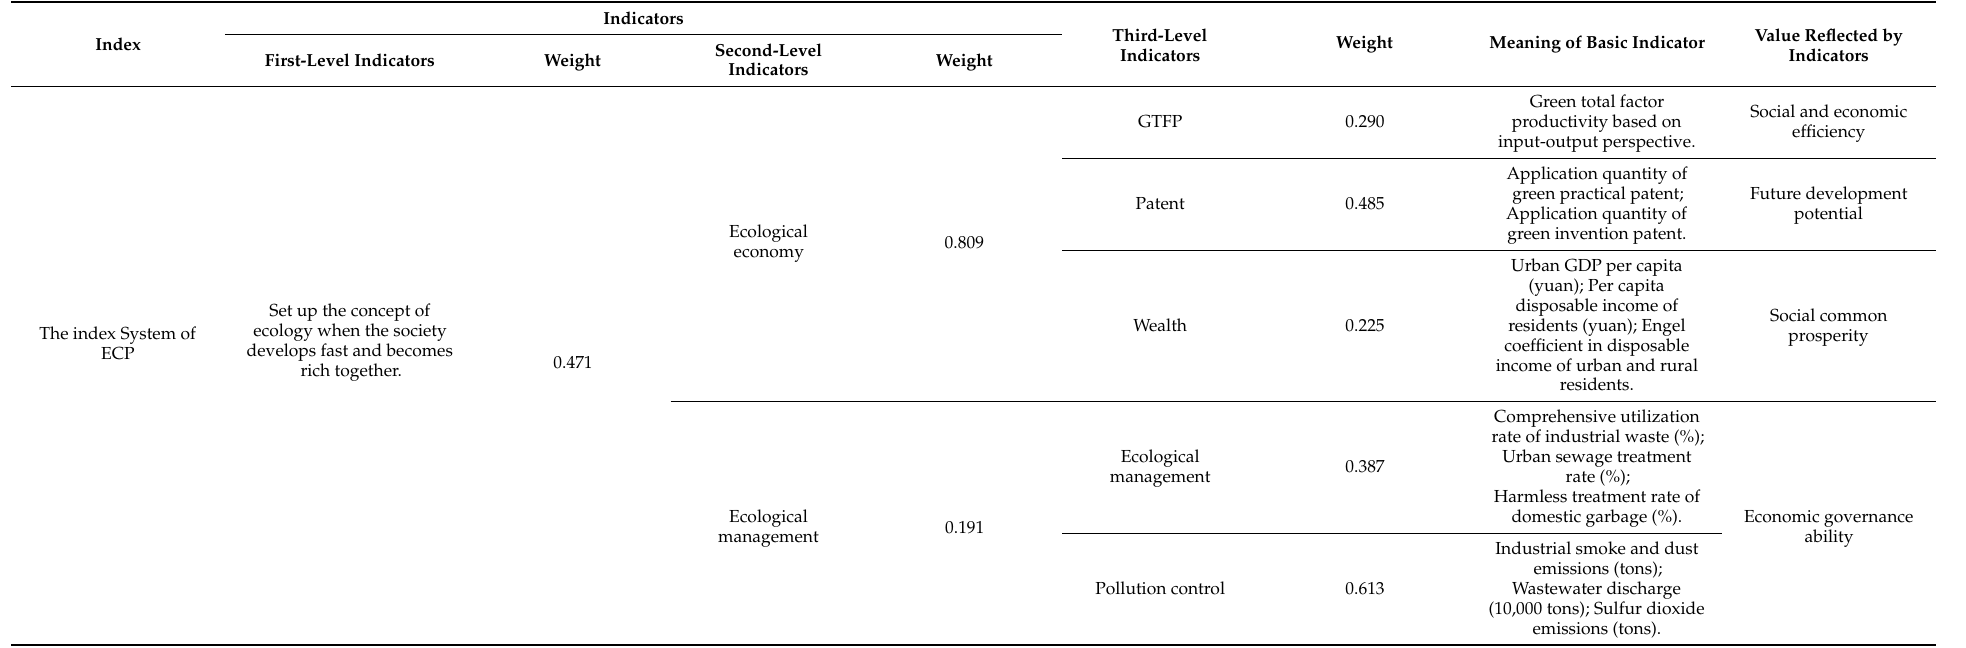
Table 1. The index system of